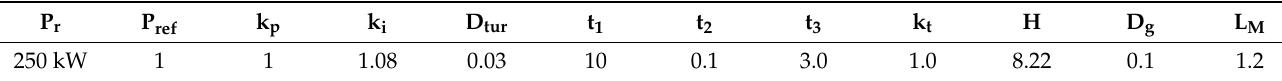
Table A5. Micro-gas turbine constant [37].